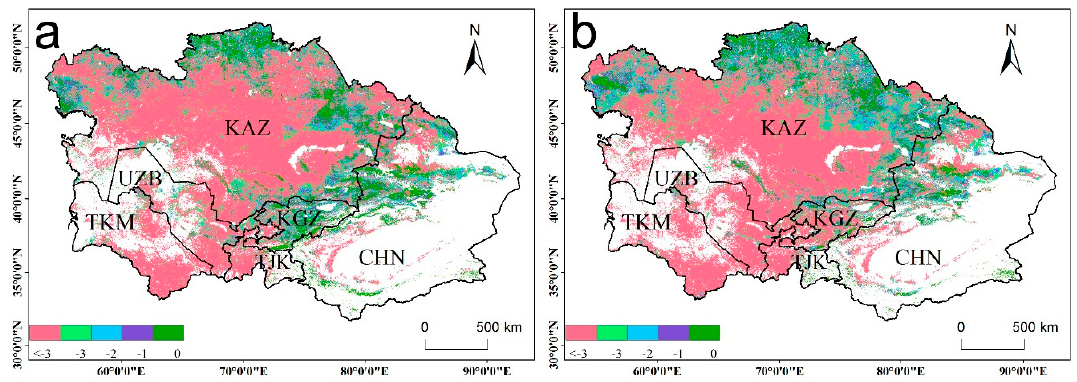
Figure 7. The difference in the Akaike Information Criterion ( Δ AIC) value between ( a ) Model 2 and Model 1, and ( b ) Model 3 and Model 2. White areas represent barren, snow, and water body pixels.